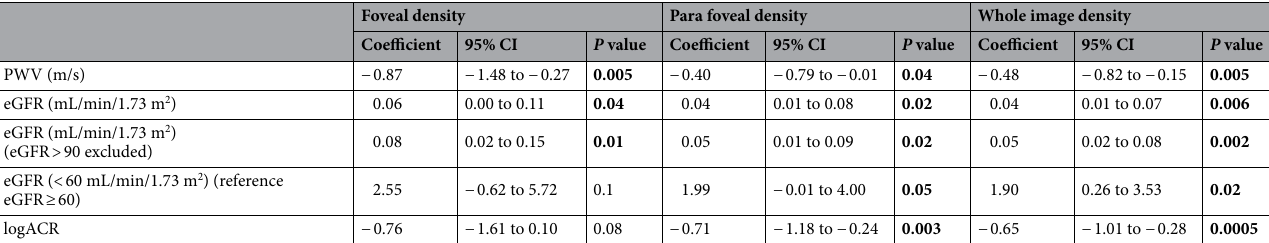
Table 3. Adjusted model results. Adjusted for age, sex, MAP and type 2 diabetes. MAP, mean arterial blood pressure; CI, confidence interval; PWV, carotid-femoral pulse wave velocity; eGFR, estimated glomerular filtration rate; ACR, albumin-to-creatinine ratio. Data were analyzed using linear regression models with generalized estimating equation. Bold face indicates statistically significant after multiple testing adjustment.